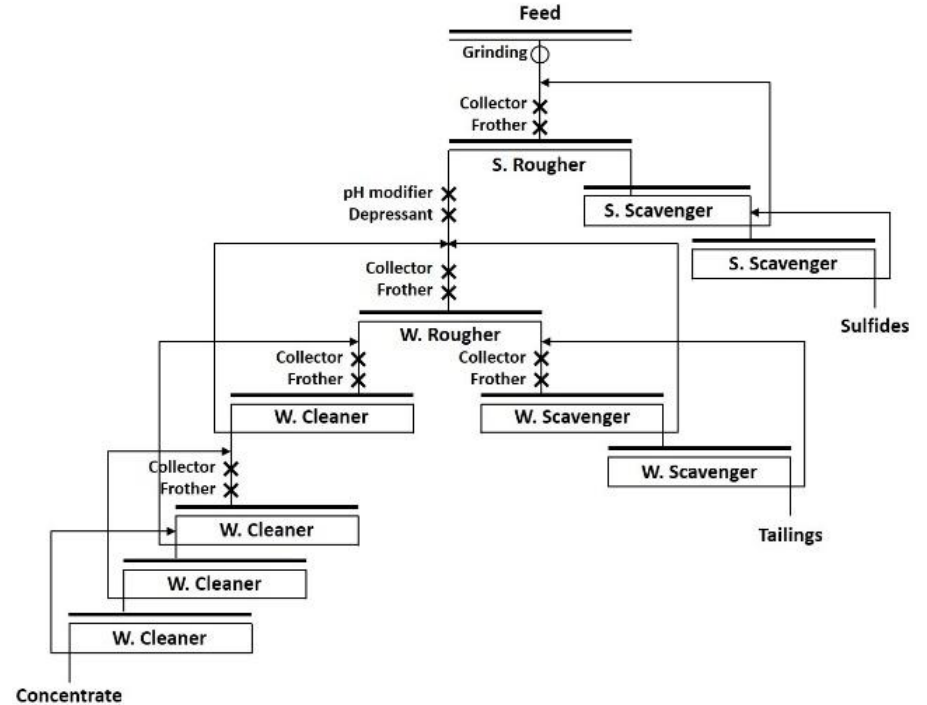
Figure 9. Flowsheet of the locked cycle test for scheelite flotation from tungsten ore.